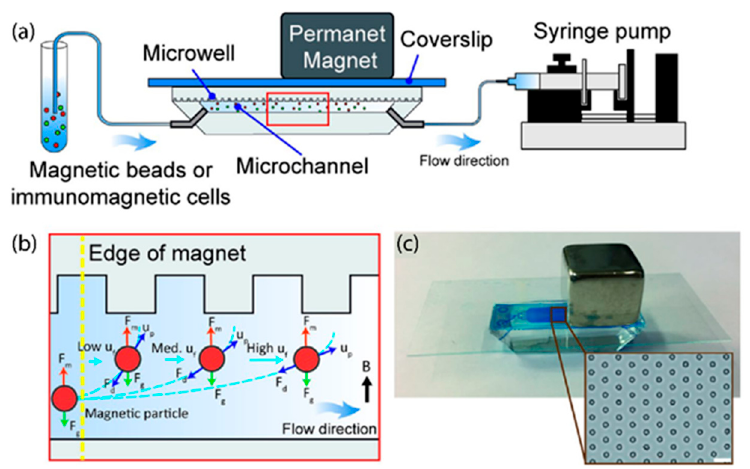
Figure 7. Magnetic trapping of individual cells in microwells. ( a ) Schematic of the system and its operation. ( b ) Illustration of the magnetic behavior of cells within the microfluidic chip. ( c ) Image of the device. The inset shows the microscopic image of the microwells. Scale bar represents 50 µm. Reproduced with permission [71]. Copyright 2021 Springer Nature.